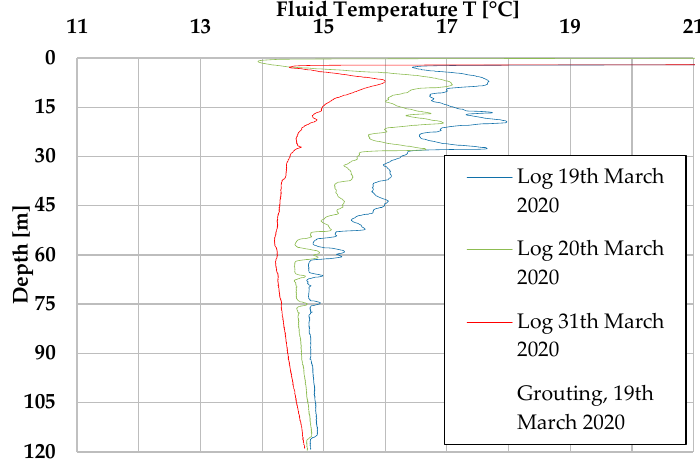
Figure 10. Vertical ground temperature profiles at the ASC-1 pilot BHE during the grout hydration period (19 September profile) as compared to the one at the end of the chemical reaction.